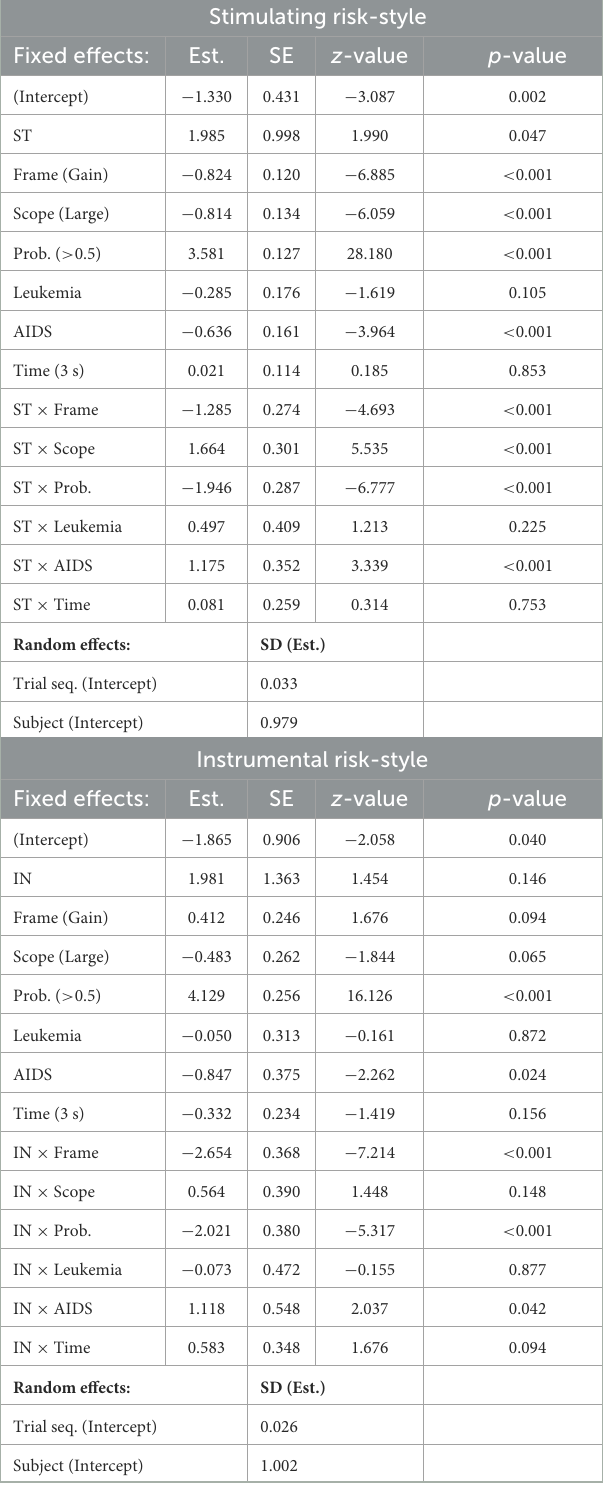
TABLE 4 Experiment 1: Generalized linear mixed models, Interactions: stimulating and instrumental risk-style. Stimulating